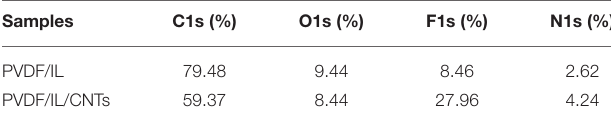
TABLE 3 | XPS surface element analysis of solid